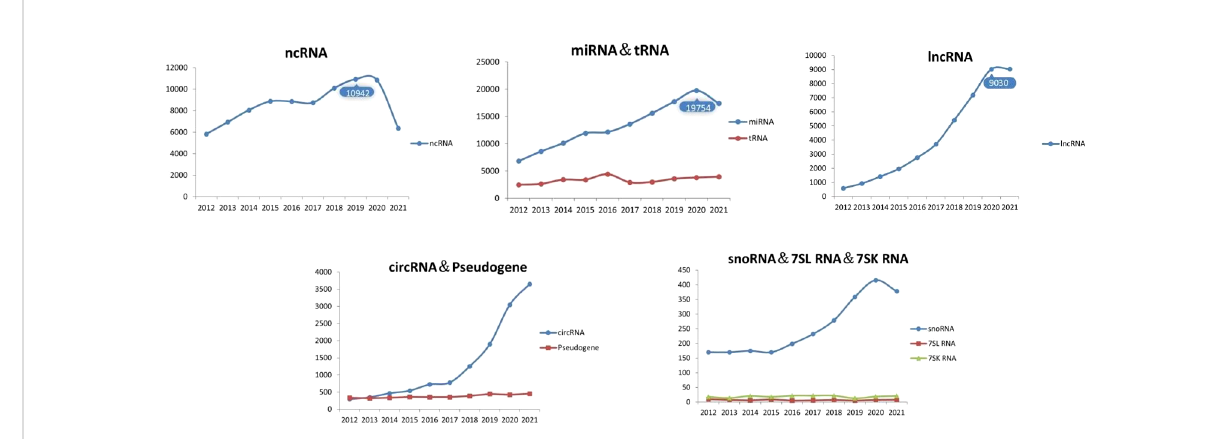
FIGURE 2 Number of articles related to